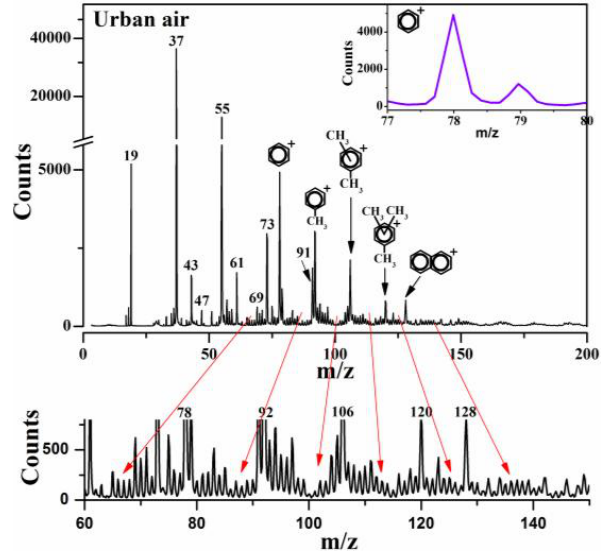
PIMS at 00:14 on 7 March 2015. The magnified plots are discussed in the